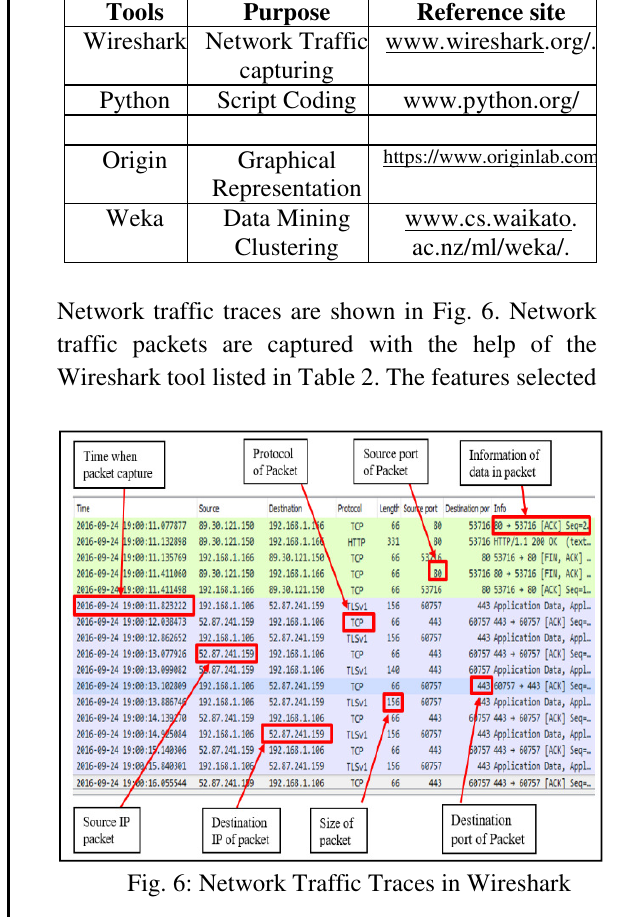
Table 2: Tools and